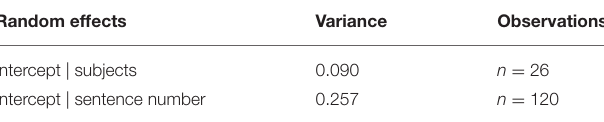
TABLE 3 | Random effects of the mixed effects logistic regression